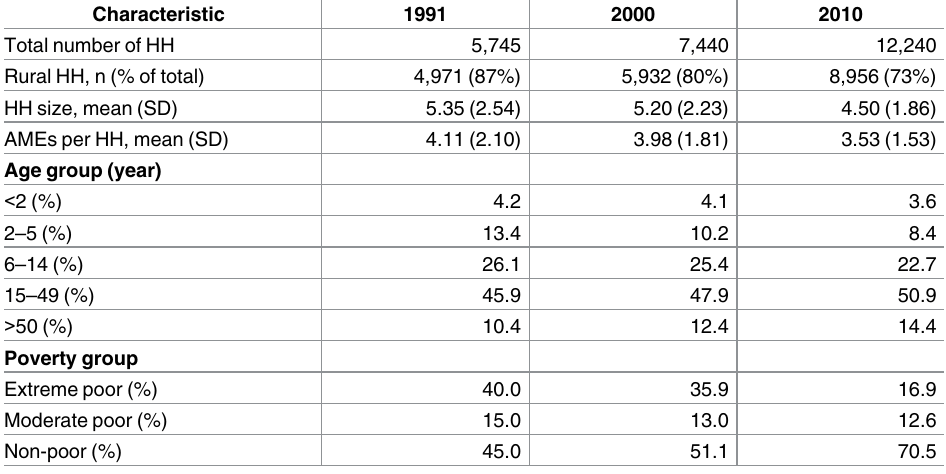
Table 1. Characteristics of surveyedhouseholds 1991–2010.